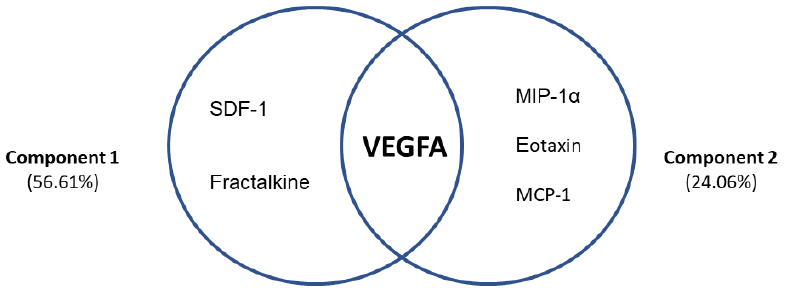
Figure 5. Exploratory principal component analysis in AUD patients with frontal deficits ( n = 51). Two components together explained 80.67% of the variance associated with frontal cognitive impairment in AUD patients.